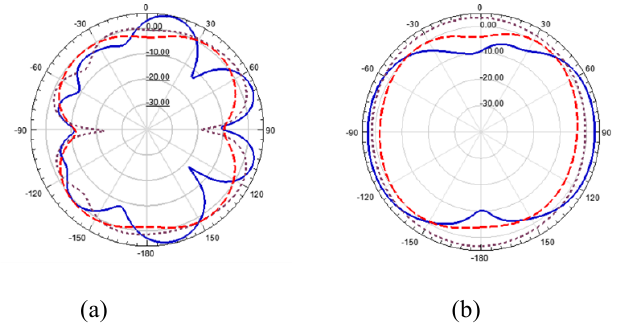
Figure 9: HFSS and CST Simulated S proposed antenna loaded with double rotational ESRRs and with non-rotational ESRRs